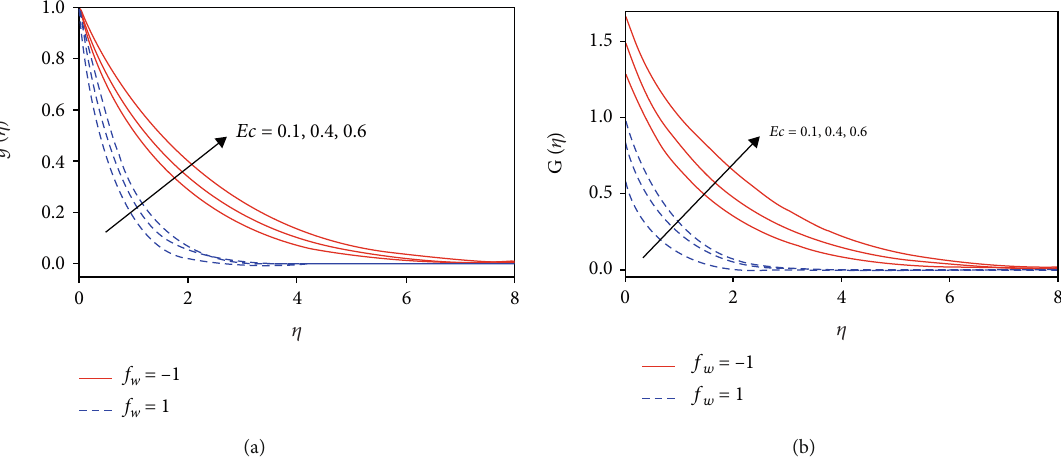
= 0 : 1, Q = 0 : 2 and Rd = 1 : (a) g in the PST case and (b) 1